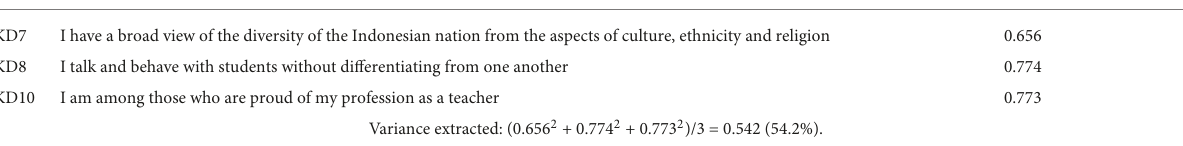
TABLE 6 The loading factor from the indicators to the teacher personality competency variables. Code Indicators